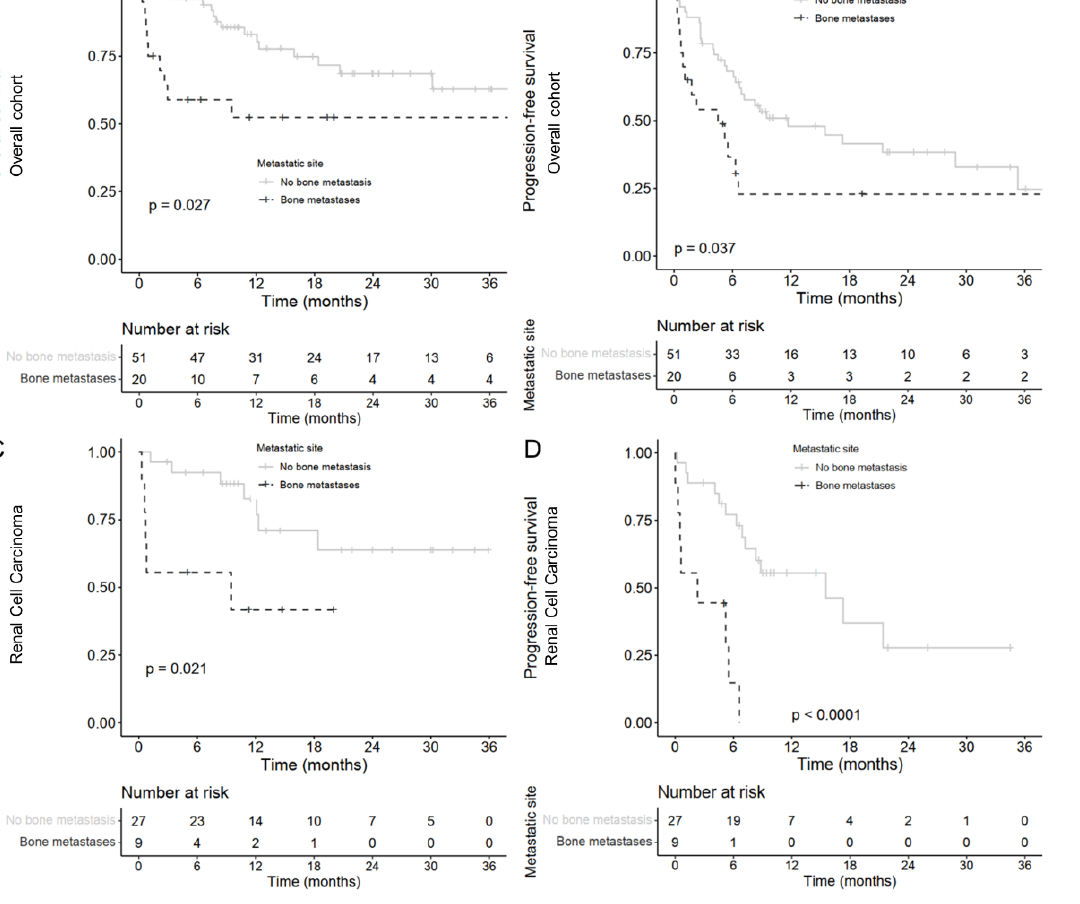
Figure 1. Kaplan – Meier estimates according to bone metastases for patients treated with ipilimumab plus nivolumab for ( A ) overall survival and ( B ) progression-free survival in the global cohort. Kaplan – Meier estimates according to bone metastases for patients treated with ipilimumab plus nivolumab for ( C ) overall survival and ( D ) progression-free survival in renal cell carcinoma.